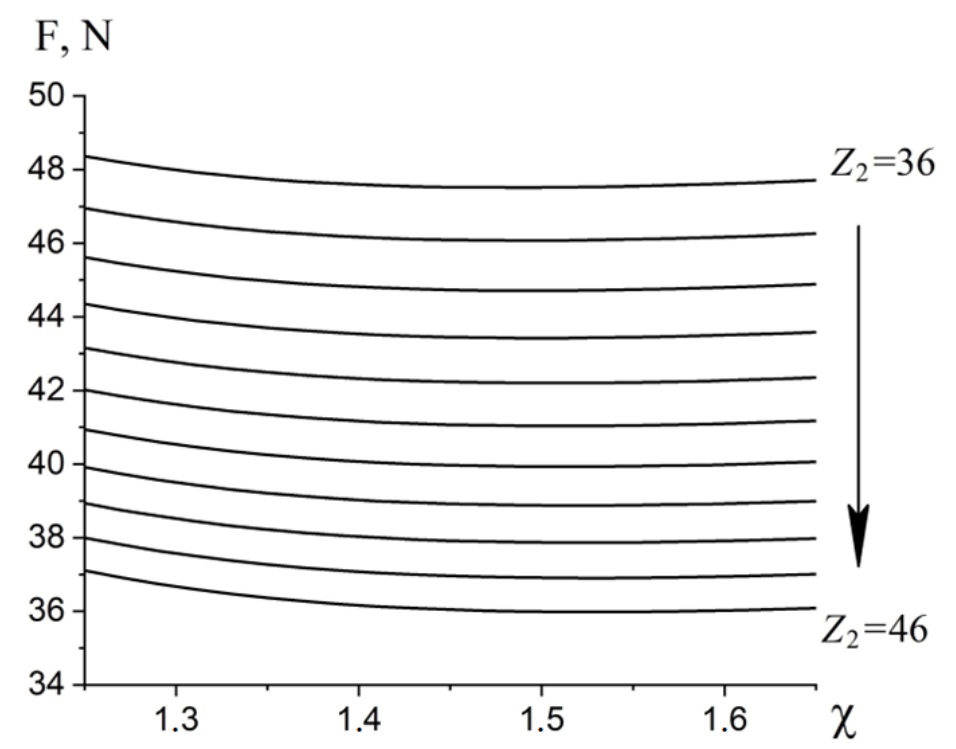
Figure 8. Dependence of the maximum force in the toothing on the displacement coefficient χ at different values of the rolling elements number Z 2 .